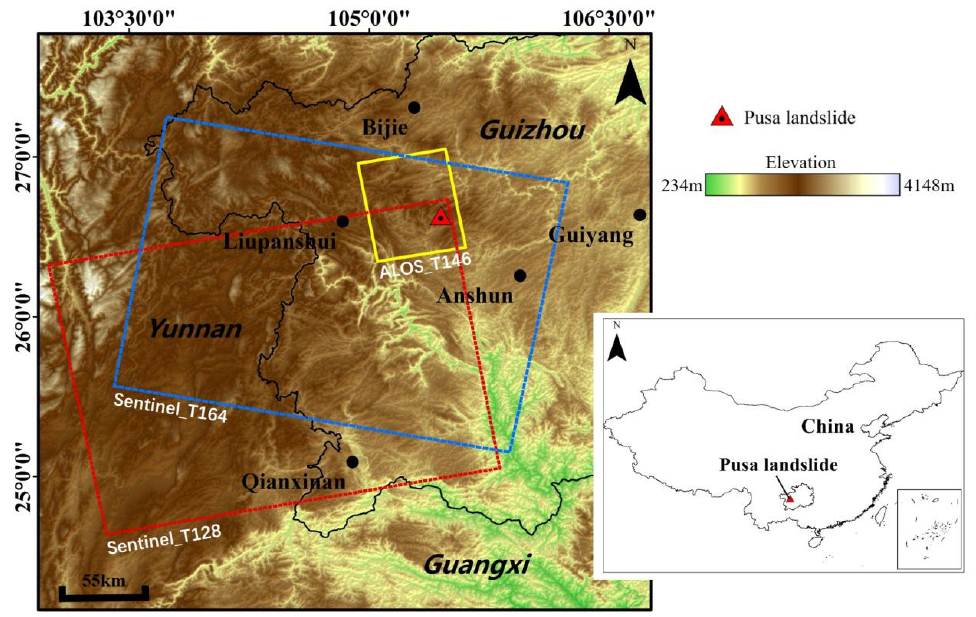
Figure 1. Study area and synthetic aperture radar (SAR) images coverage. The background is the shaded relief of the shuttle radar topography mission (SRTM) digital elevation model. The inset indicates the landslide location in China. Remote Sens. 2020 , 10 , x FOR PEER REVIEW